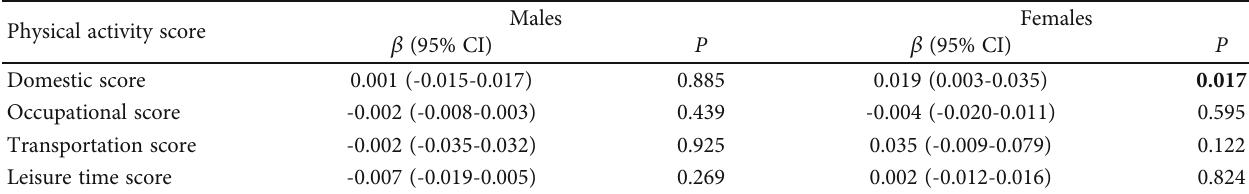
Table 3: The analysis of subgroup considering di ff erent genders.